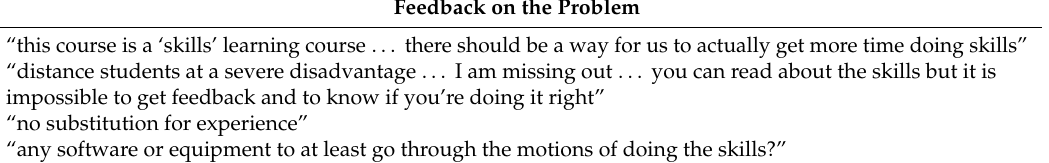
Table 2. Data Supporting “What is the problem?” step of the Pedagogy before Technology model, as per Figure 3.